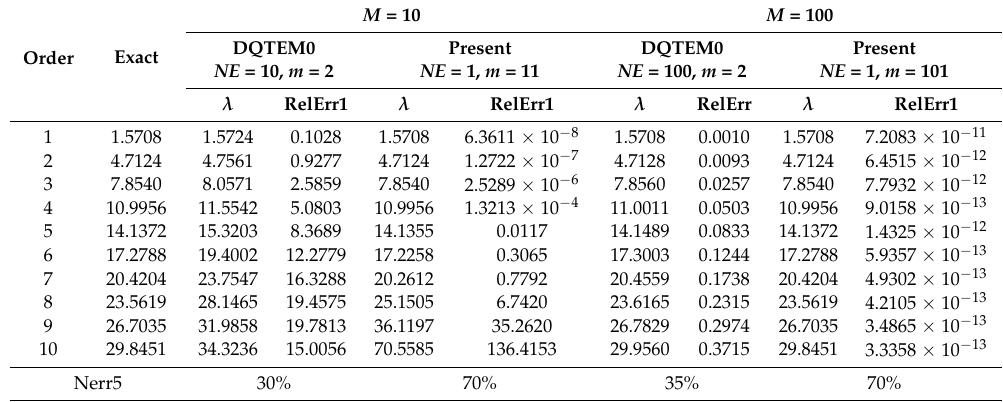
Table 5. Frequency parameter λ of rod by linear rod element and DQ (Differential Quadrature) element.